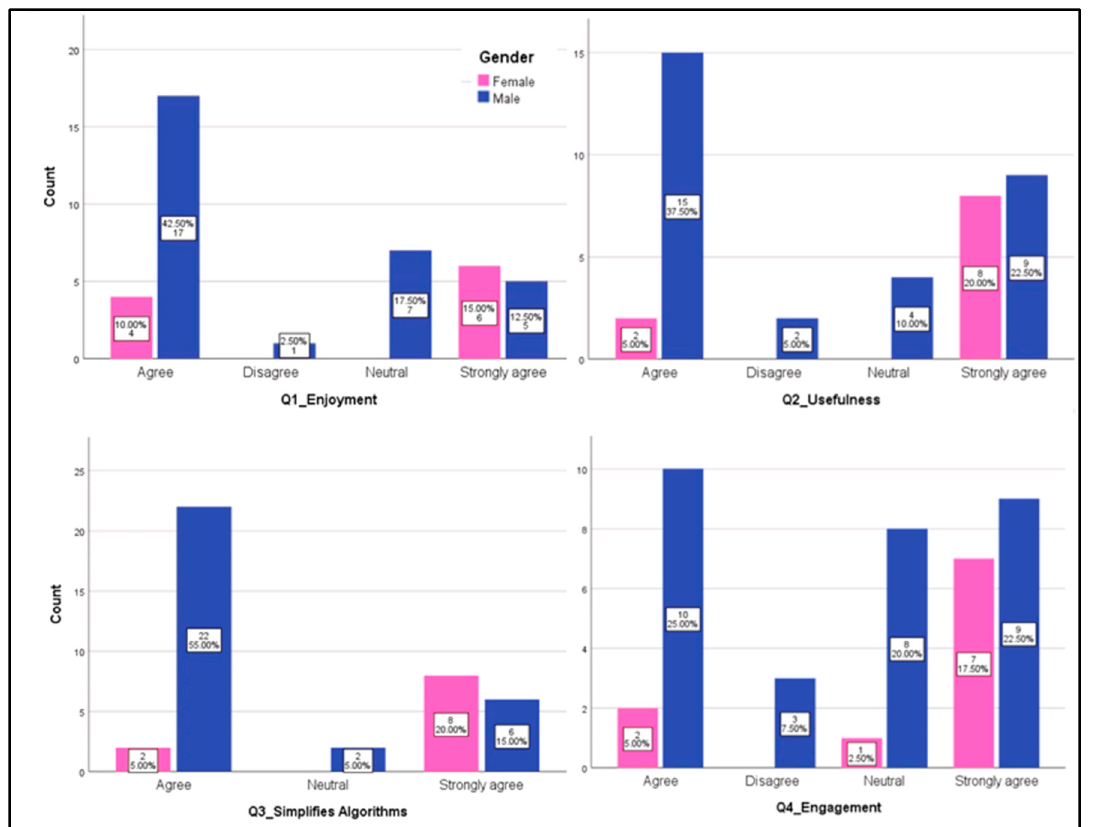
Figure 13. Students’ responses to game activities for both genders.